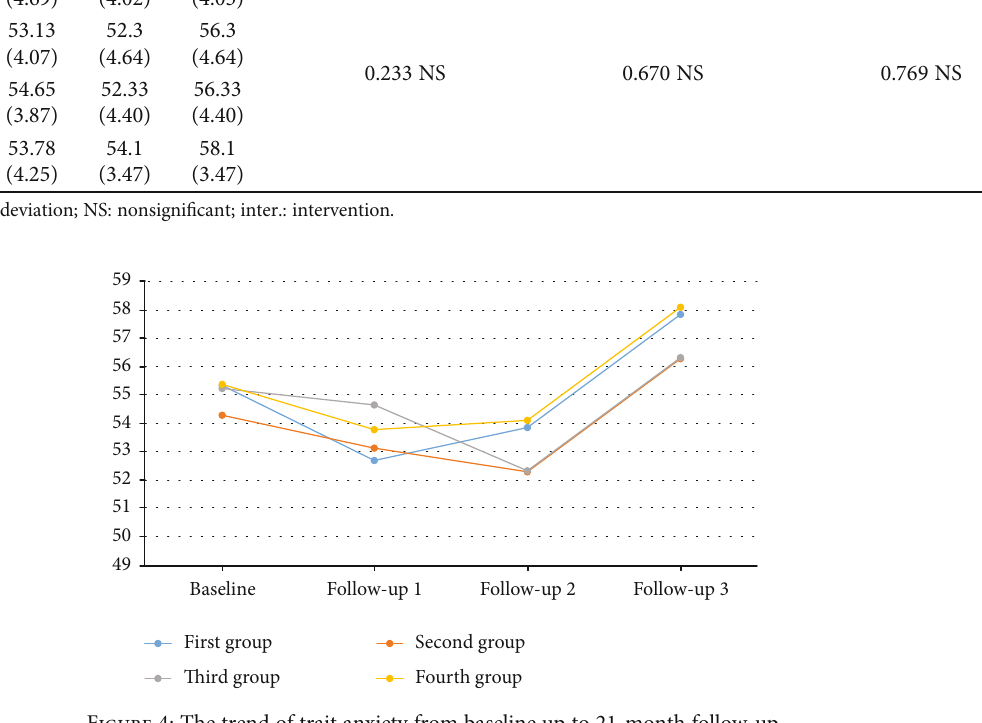
Figure 4: The trend of trait anxiety from baseline up to 21-month follow-up. Table 5: Comparisons between trial and control groups in terms of ICU working stress at baseline (time 1), 6 months (time 2), 15 months (time 3), and 21 months (time 4) after the